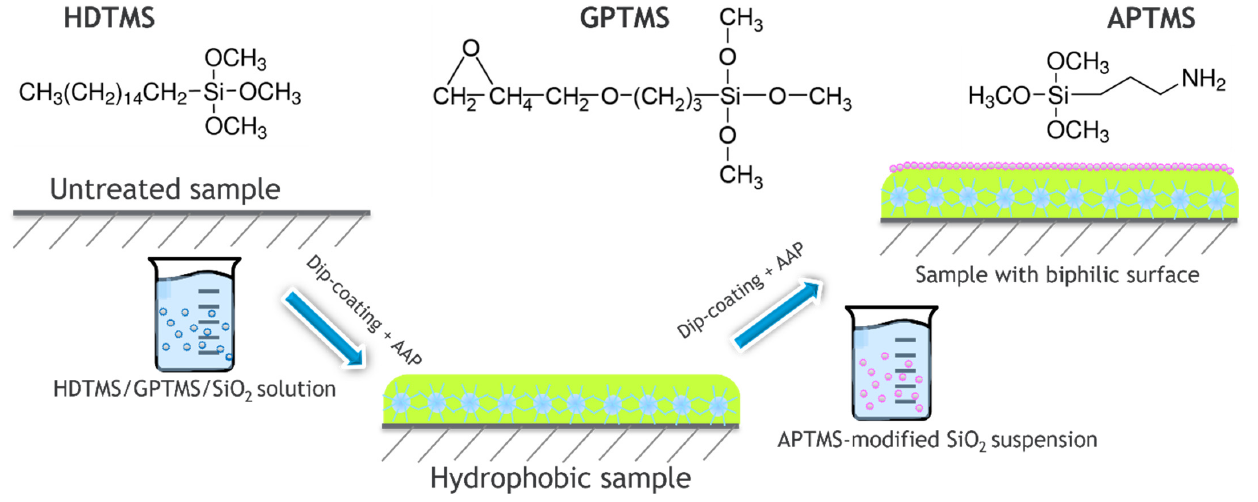
Figure 2. Scheme for the nanofiltration membranes preparation using atmospheric air plasma and modifications by dip-coating.